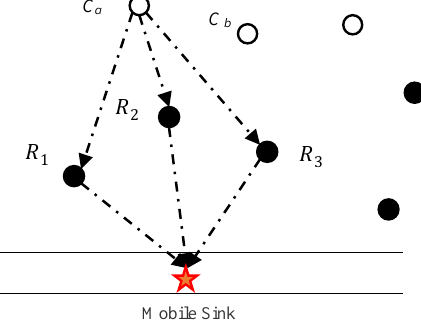
Figure 6. Schematic diagram of transmission path selection